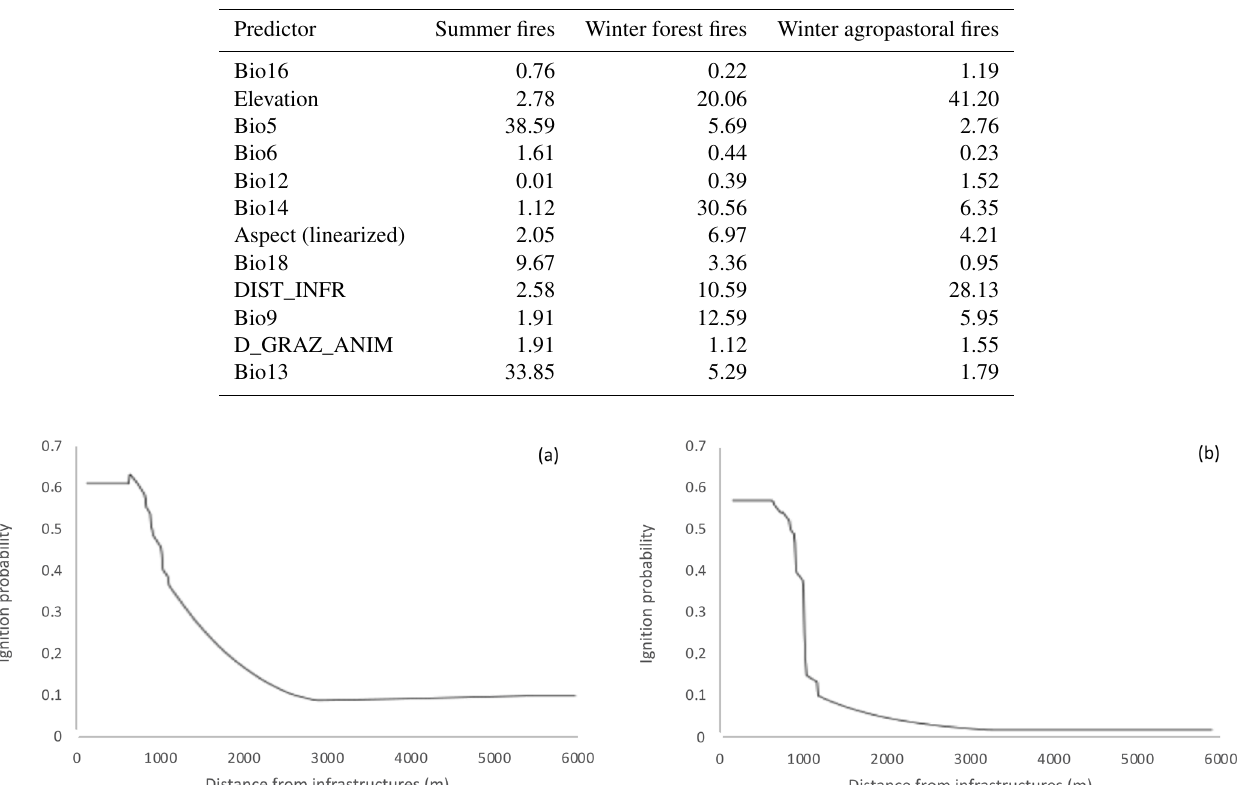
Table 3. Predictor PPI (percent permutation importance) in the models for ignition of summer, winter forest, and winter agropastoral fires.